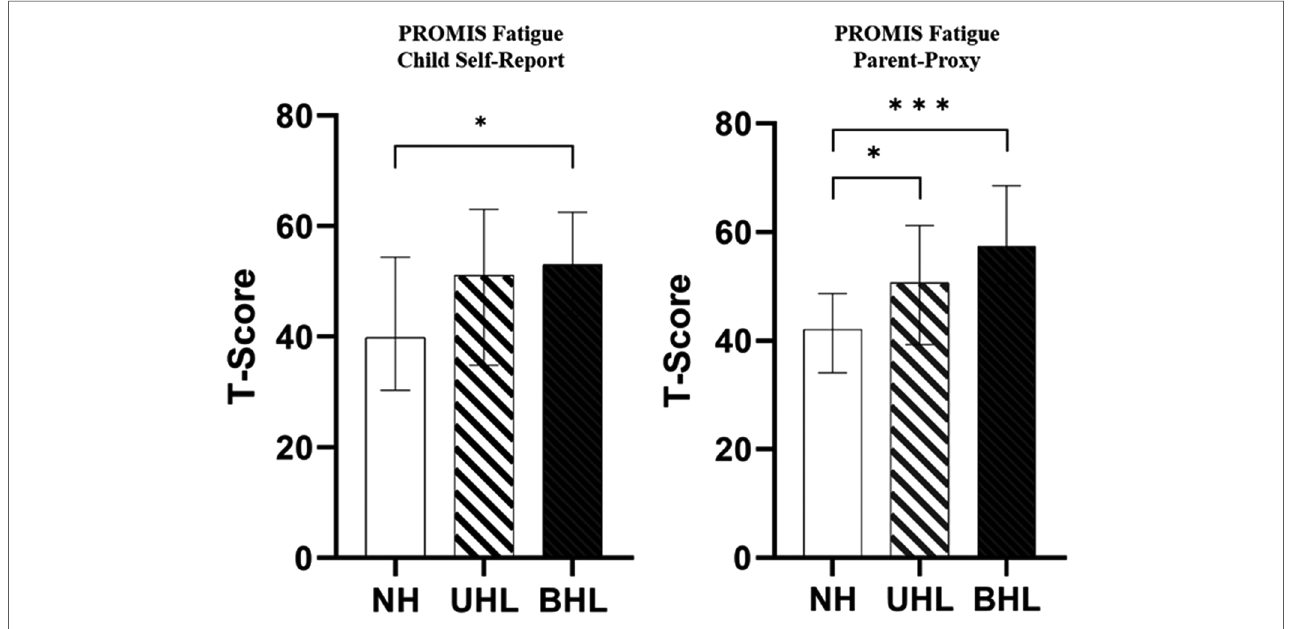
FIGURE 4 Median PROMIS fatigue short form 10a T-scores for the child self-report (left) and parent-proxy (right) respondents. Higher values indicate greater fatigue. Bars and error bars shown represent medians±IQRs. CNH; white bars, CUHL; oblique stripes, CBHL; black bars respectively. Asterisks show signi fi cant differences between groups (* p <0.05, ** p <0.01, *** p